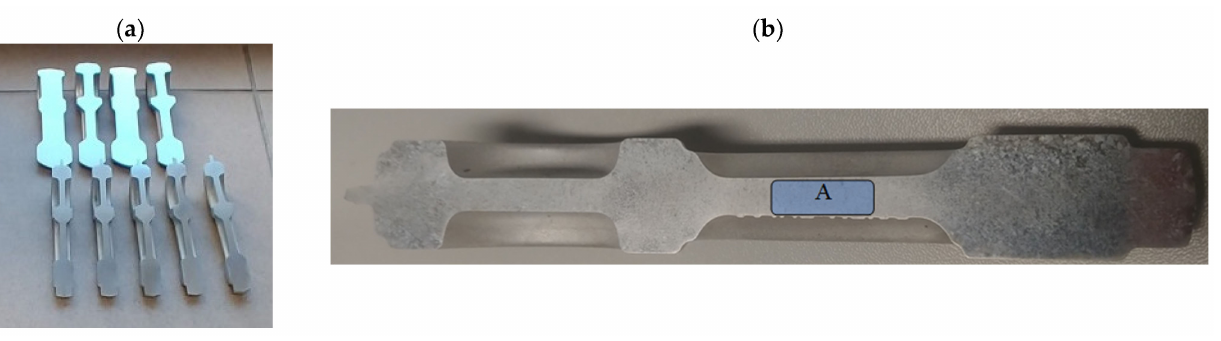
Figure 13. Analyzed cross-sections of connecting rods during preparation ( a ) and the tested area of preforms and forgings ( b